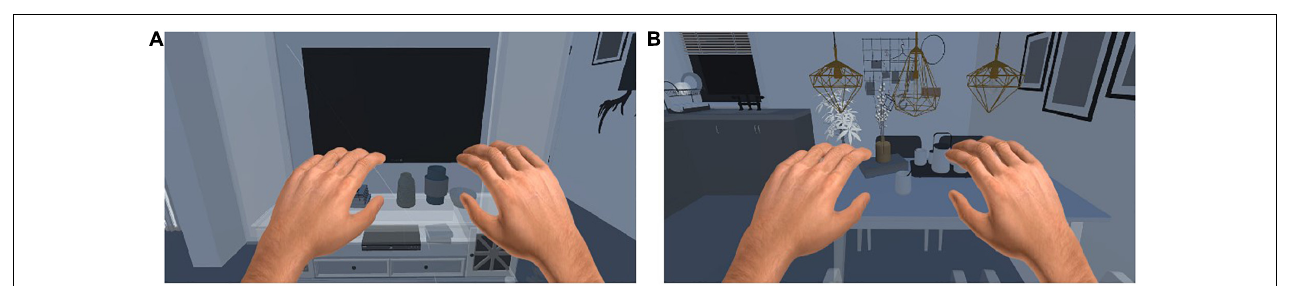
FIGURE 2 | Static and dynamic scenes without VR.